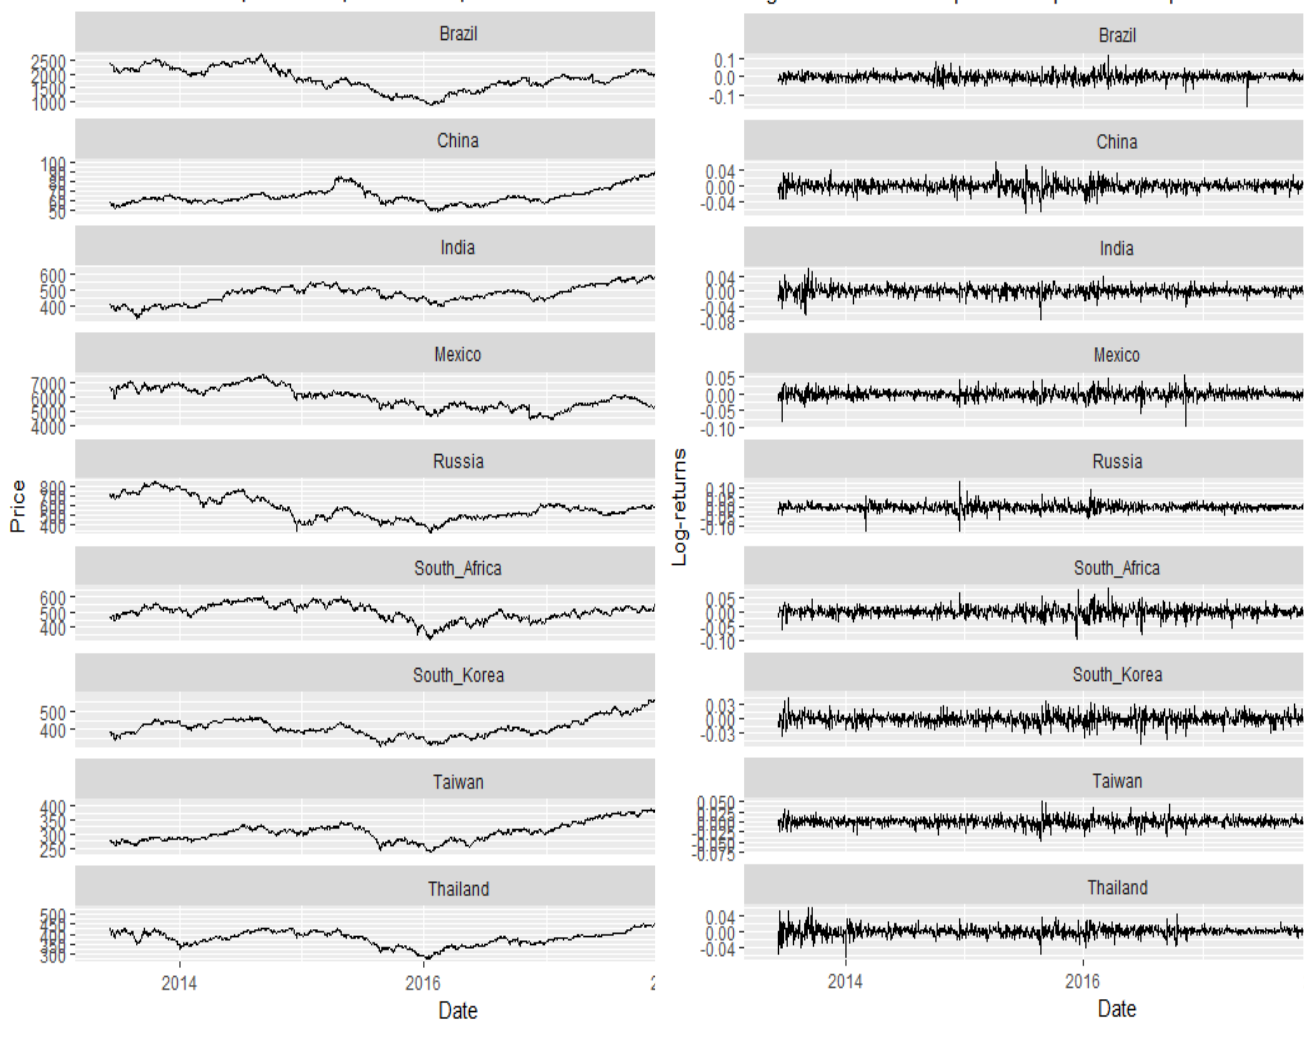
Figure 2. Price and log-return plots of the top 9 EMs equities in PC period. Table 2. Summary statistic of EM